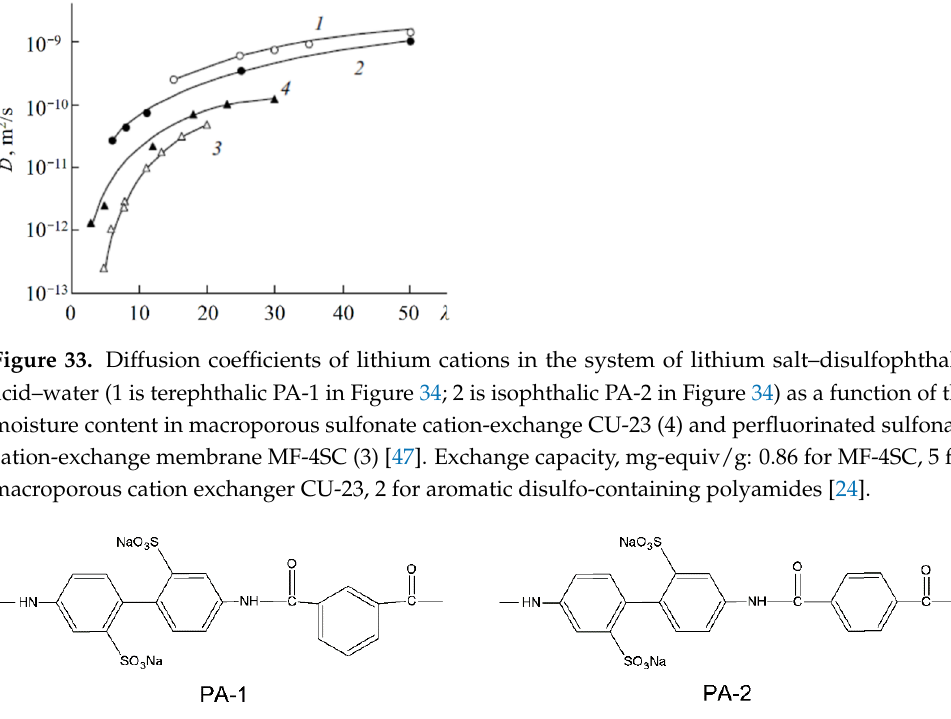
Figure 34. Chemical structure of sulfo-containing aromatic polyamides PA-1 and PA-2.